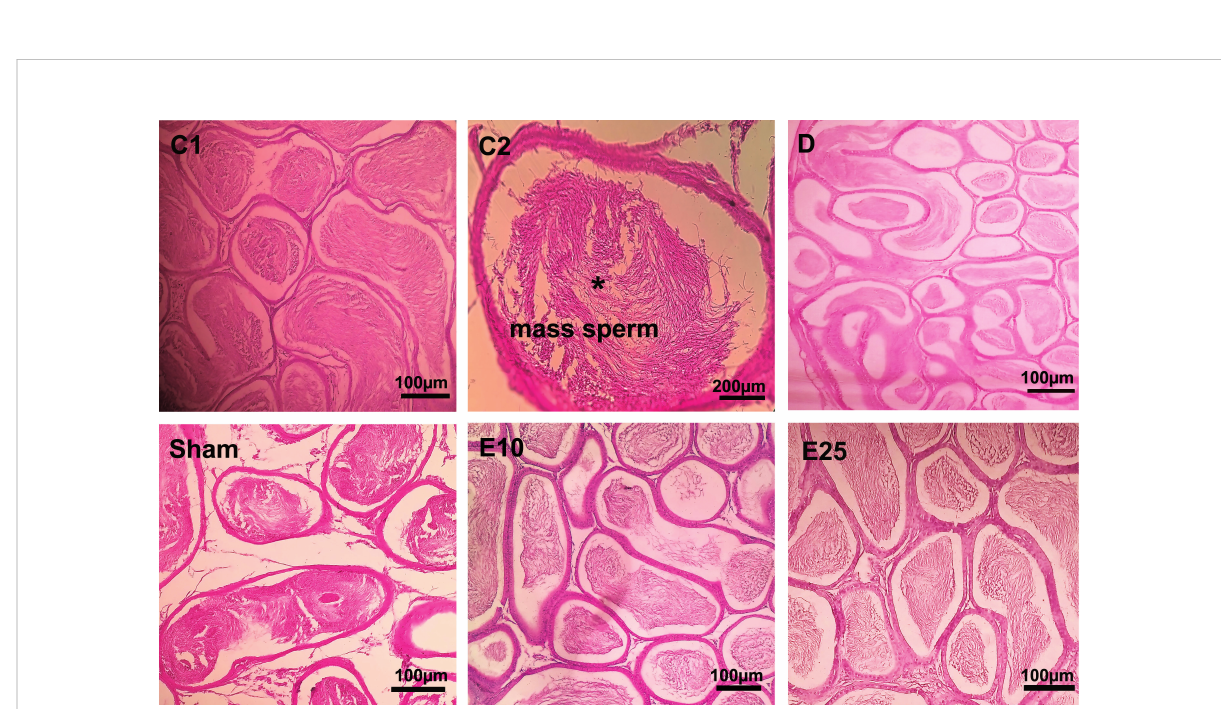
FIGURE 3 Epididymis cross-section. C1: control rats (magni fi cation x400), C2: control rats (magni fi cation x1000), D: diabetes group, sham: diabetic rats that received distilled water for 8 weeks, E10: empagli fl ozin-10 group (diabetic rats that received 10 mg/kg/day empagli fl ozin for 8 weeks, E25: empagli fl ozin-25 group (diabetic rats that received 25 mg/kg/day empagli fl ozin for 8 weeks. Magni fi cation of D, sham, E10, and E25: